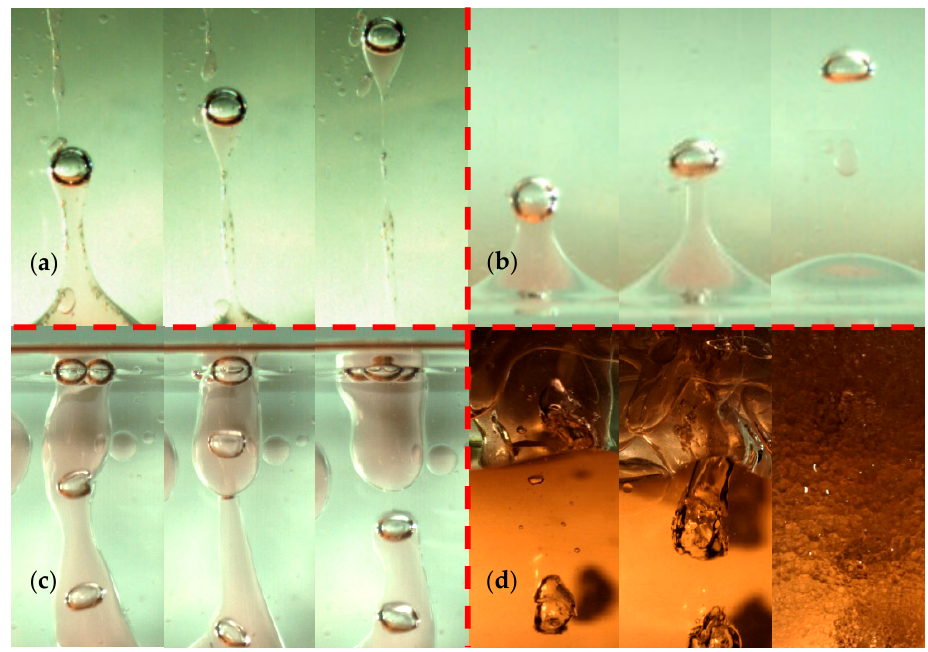
Figure 7. Four mechanisms of liquid entrainment with an oil–oil viscosity of 50 cSt for ( a ) Q = 50 mL/min; ( b ) Q = 100 mL/min; ( c ) Q = 250 mL/min and ( d ) Q = 4000 mL/min.